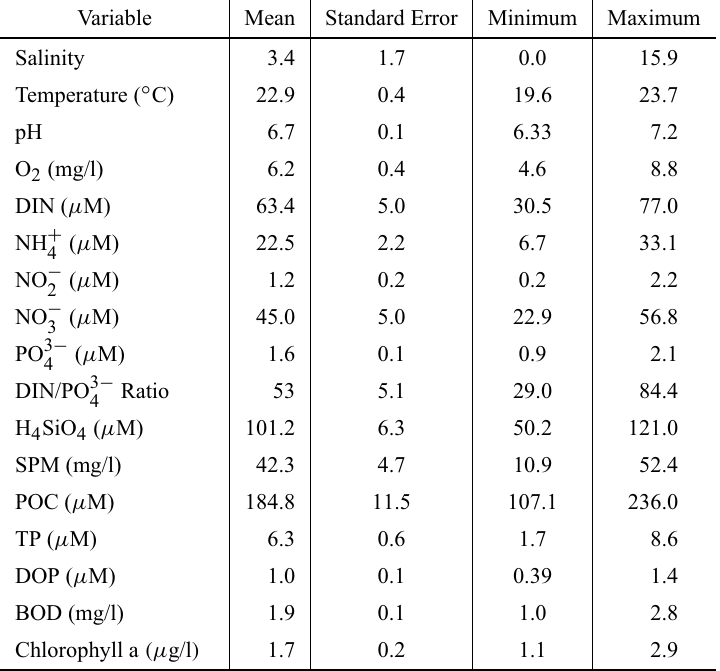
Summary of the results obtained in the Itajaí River estuary, in samples carried out in 2003 and 2004. The averages, standard, minimum and maximum errors were calculated among the averages obtained for the sampling